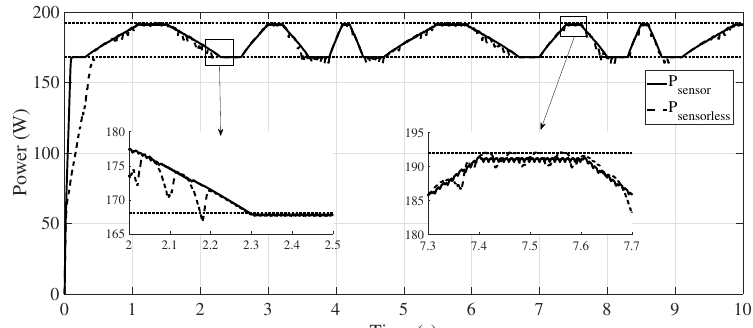
Figure 14. Generated power.